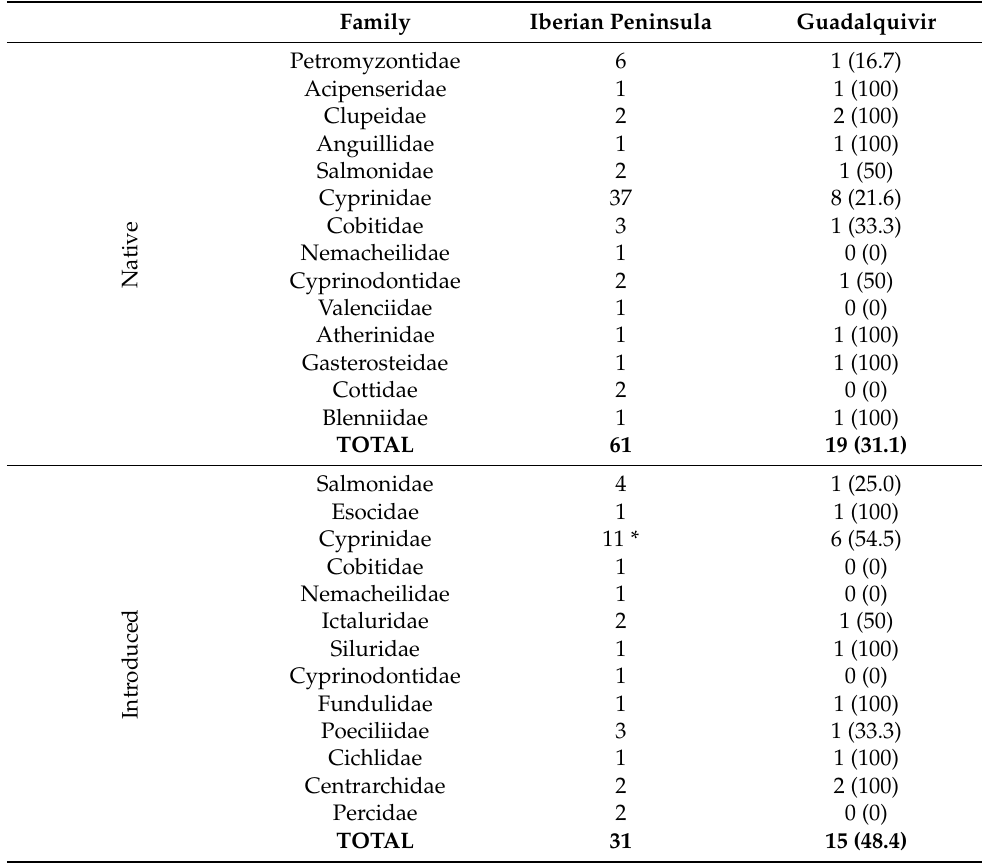
Table 2. Families and number (%) of Iberian freshwater fish species recorded in the Guadalquivir River Basin. Sources: Carta Pisc í cola Española for Spanish data (http://www.cartapiscicola.es, ac- cessed on 27 September 2022) and Fishbase for Portuguese data (http://www.fishbase.org/Country/ CountryChecklist.php?showAll=yes&c_code=620&vhabitat=fresh, accessed on 15 July 2022). * Tinca tinca is considered introduced according